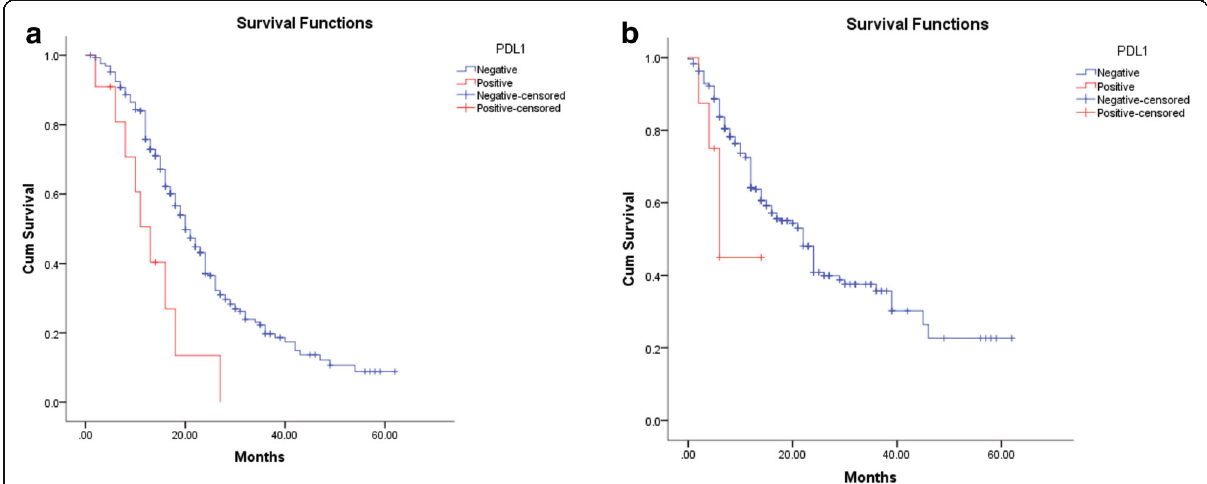
Fig. 2 Kaplan-Meier plots of PD-L1 for OS and PFS. a Kaplan-Meier plot for OS showed that patients with PD-L1 positivity had significantly poorer OS than did PD-L1-negative individuals. b Kaplan-Meier plot for PFS showed that patients with PD-L1 positivity also had poorer PFS than did PD- L1-negative individuals. OS: overall survival; PFS: progression-free